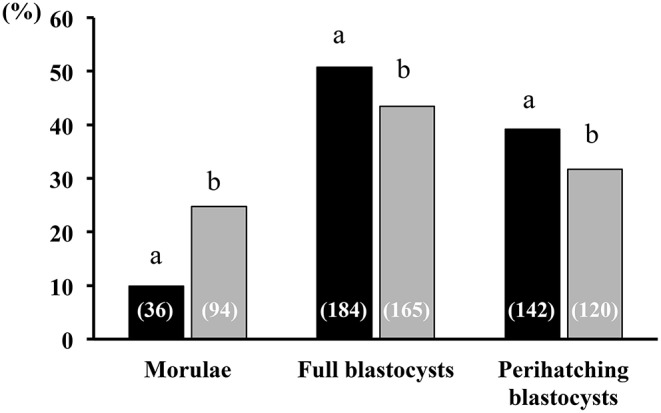
Embryonic developmental stage at collection. Developmental stages of embryo recovery 6 days after heterologous seminal plasma (SP; black bars; N = 16 sows) or BTS (Control; gray bars; N = 18 sows) infusions prior to insemination. Thirty minutes before each postcervical insemination (1.5 × 109 sperm/dose in 40 mL of BTS diluent), sows were infused with 40 mL of heterologous SP or BTS (control). At day 6 after the first insemination, the sows were subjected to laparotomy to collect the embryos and to evaluate their quality and developmental stage. A total of 362 and 379 viable embryos were collected in sows from the SP and BTS groups, respectively. Numbers in parentheses are the number of embryos for each stage. a,bDifferent letters within each embryonic developmental stage represent significant differences (P < 0.05; Fisher's exact test).